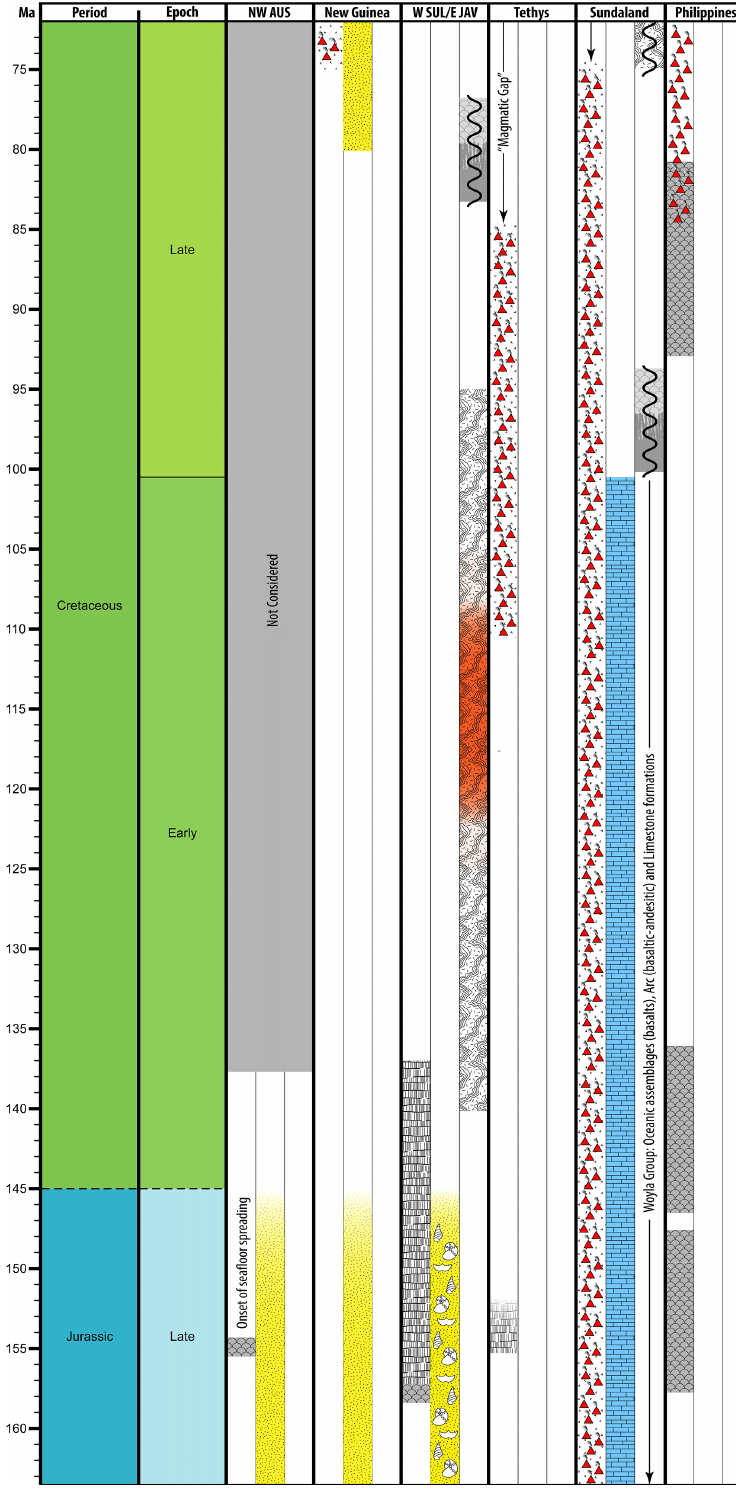
Fig. 3. Summary of first-order tectonic events related to the latest Jurassic Gondwana rifting and the evolution of the Tethys and Sunda region since the Cretaceous. For each region major volcanic (left column), sedimentary (middle column) and metamorphic (right column) events are documented. HEB–Hawaiian–Emperor Bend time based on Sharp and Clague (2006), K/L–Kohistan–Ladakh, PA-F-T=Prince